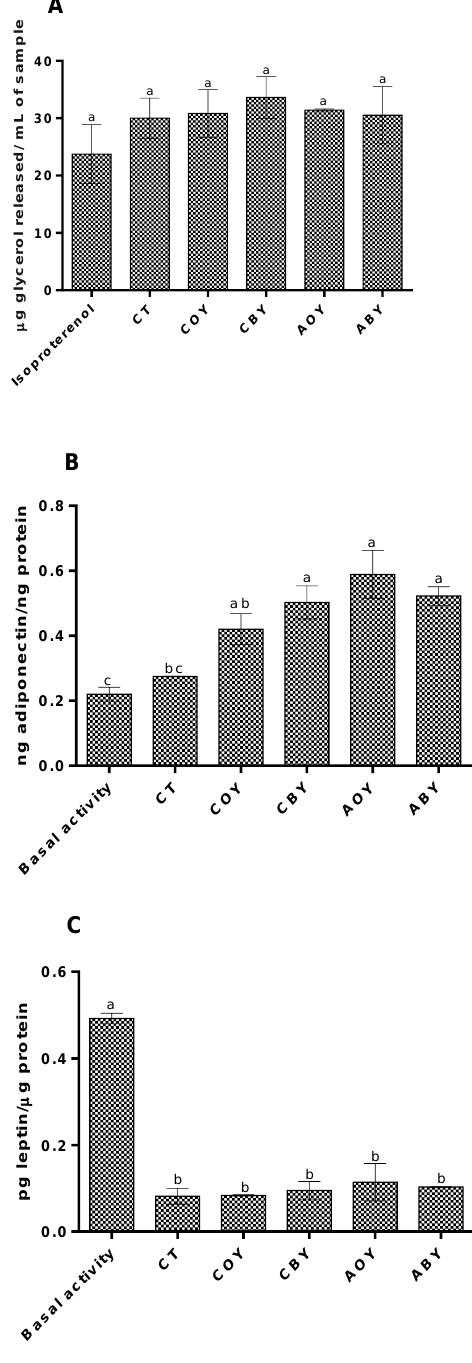
Figure 4. Effect of yogurts on adipolysis and adipokines secretion. ( A ) adipolysis; ( B ) adiponectin; ( C ) leptin. Different letters mean significant differences as determined by a one-way ANOVA test ( p < 0.05) between samples. CT—control yogurt, COY—coconut oil yogurt; CBY—coconut bigel yogurt; AOY—avocado oil yogurt; ABY—avocado bigel yogurt.